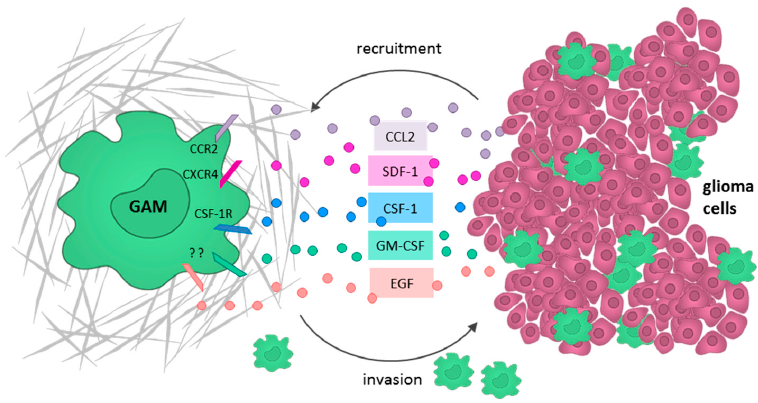
Figure 3. Recruitment of glioma-associated microglia/macrophages (GAMs) by glioma cells through the secretion of soluble factors, such as CCL2 (violet), SDF-1 (pink), CSF-1 (blue), GM-CSF (green), and EGF (red)